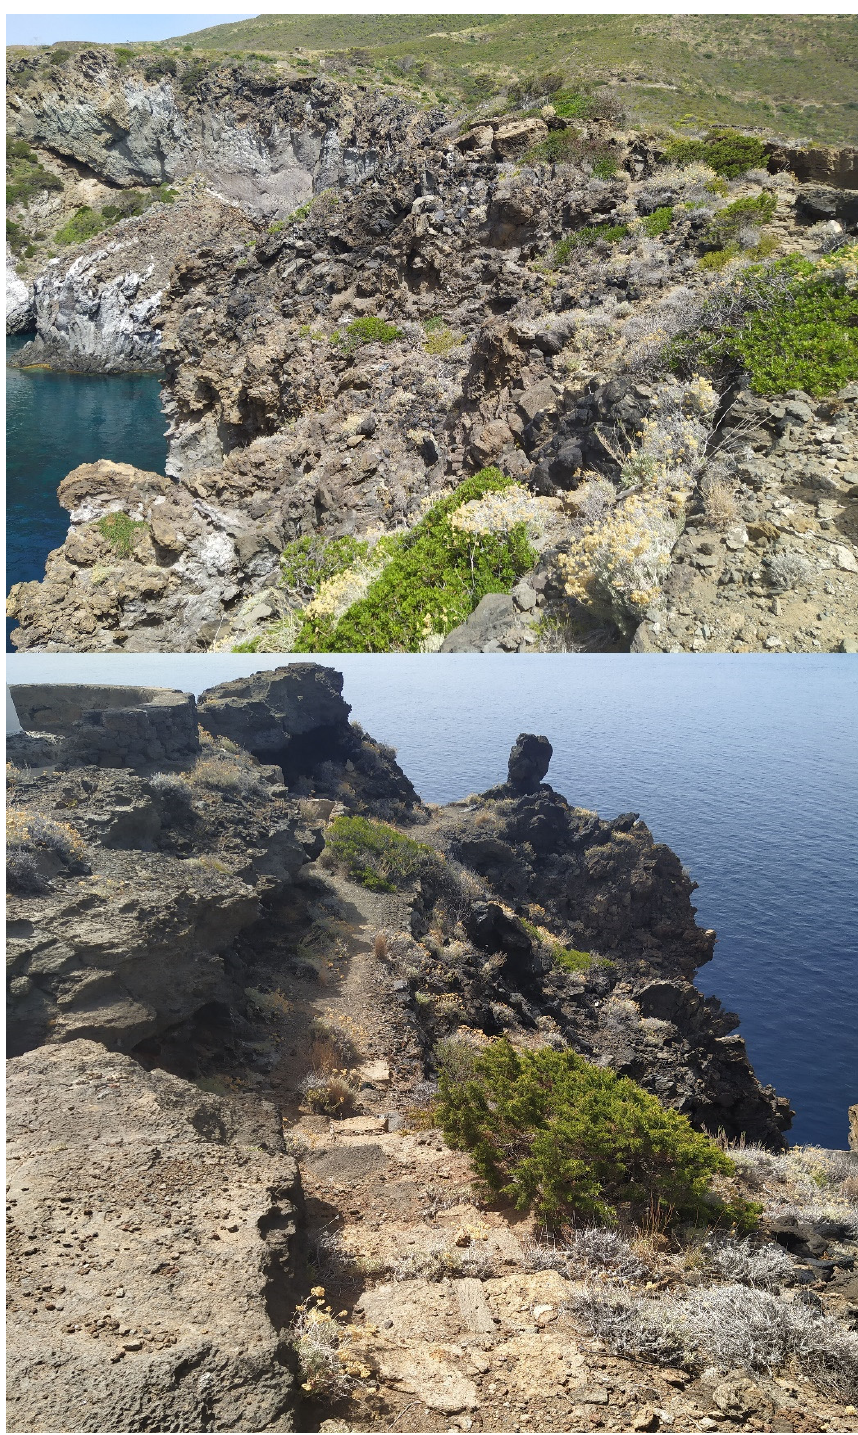
Figure 12. Habitat of Acheta pantescus n. sp. in the locality Punta Limarsi, next to the lighthouse.